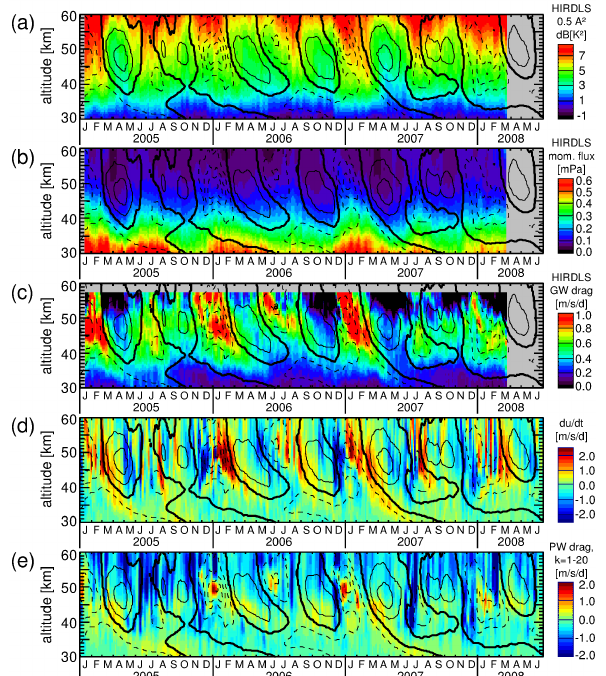
Figure 2. Altitude–time cross sections of averages over the lati- tude band 10 ◦ S–10 ◦ N. (a) HIRDLS gravity wave squared temper- ature amplitudes determined in 10km vertical windows from the HIRDLS altitude profiles. Values were divided by 2 to be compara- ble to gravity wave variances. Units in (a) are dB(K 2 ). (b) HIRDLS total gravity wave momentum fluxes in mPa from a gravity wave analysis using a 10km vertical window covering vertical wave- lengths < 25km, and (c) total gravity wave drag obtained from ver- tical gradients of the HIRDLS momentum fluxes shown in (b) . For comparison, ERA-Interim (d) ∂u/∂t and (e) planetary wave drag ( k = 1–20) are repeated from Fig. 1b and c, respectively. Units in (c–e) are ms − 1 d − 1 . Contour lines indicate the zonal wind: west- ward wind is dashed, and the bold contour line indicates zero wind. Contour increment is 20ms − 1 .